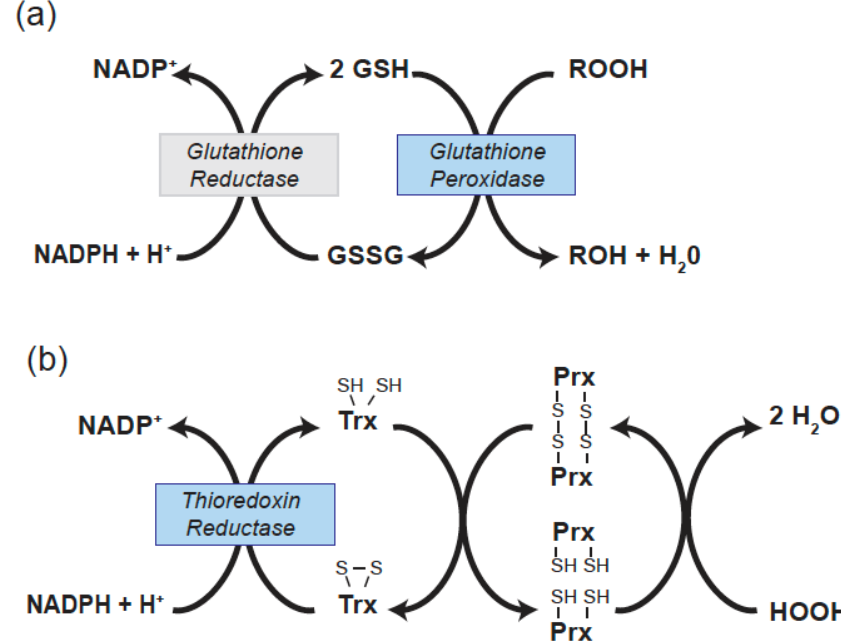
Figure 1. Redox pathways involved in the reduction of cellular peroxides. ( a ) Glutathione peroxidase reduces hydrogen and lipid hydroperoxides (ROOH) to the corresponding alcohol (ROH) and water using GSH ( glutathione ) as a reductant, resulting in the formation of oxidized glutathione (GSSG). Glutathione reductase is an NADPH-dependent enzyme that maintains the pool of reduced GSH. ( b ) Thioredoxin reductase is an NADPH-dependent enzyme that maintains the pool of reduced thioredoxin (Trx). Thioredoxin reduces the peroxiredoxin (Prx) proteins that consume hydrogen peroxide. Cys-Cys dithols are indicated by S-S, and reduced thiols by SH in the figure. In humans there are 4 methionine sulfoxide proteins (MsrA, MsrB1, MsrB2,